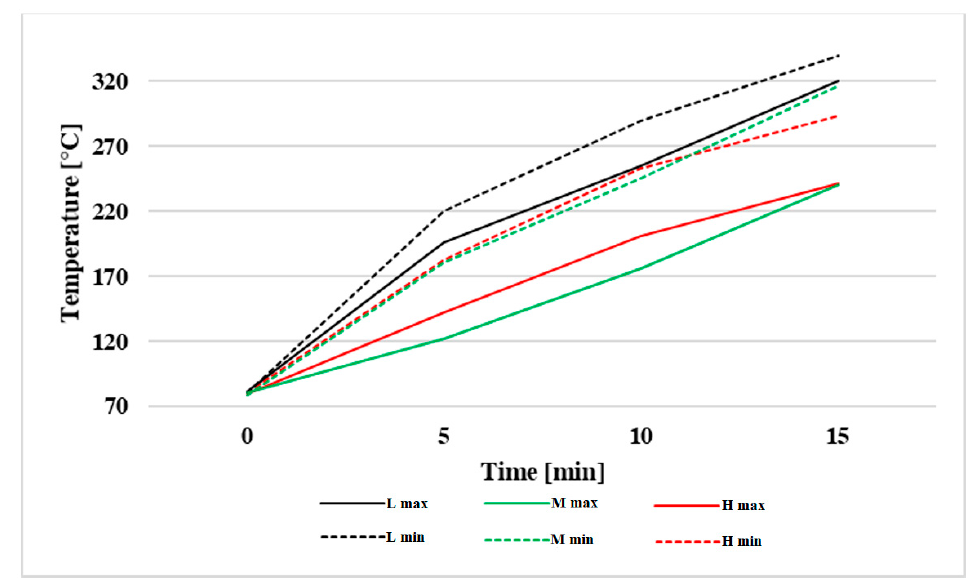
Figure 10. Temperature of brake discs during continuous braking. During continuous braking and wheel rotating at a low speed of 10 km.h − 1 , the tem- perature of the low-priced brake discs with minimum thickness reached 339 °C, and the